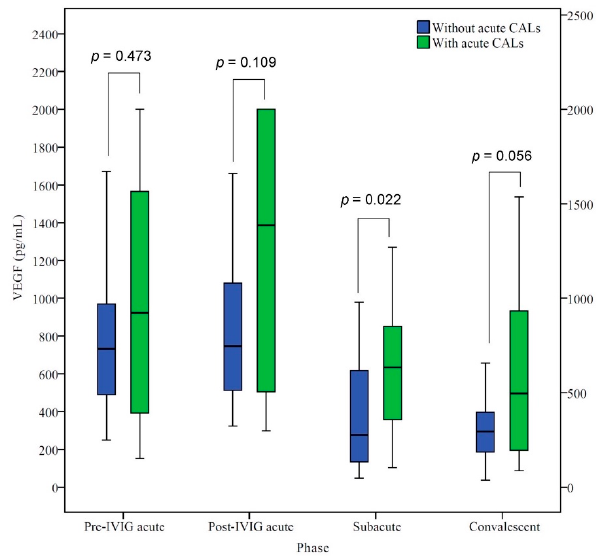
Figure 2. Comparisons of vascular endothelial growth factor (VEGF) levels between KD patients with/without acute CALs. Central box, values from the lower to upper quartile (25th–75th percentile). In the box plots, the middle line represents the median. The p -value was estimated by the Mann–Whitney U test.